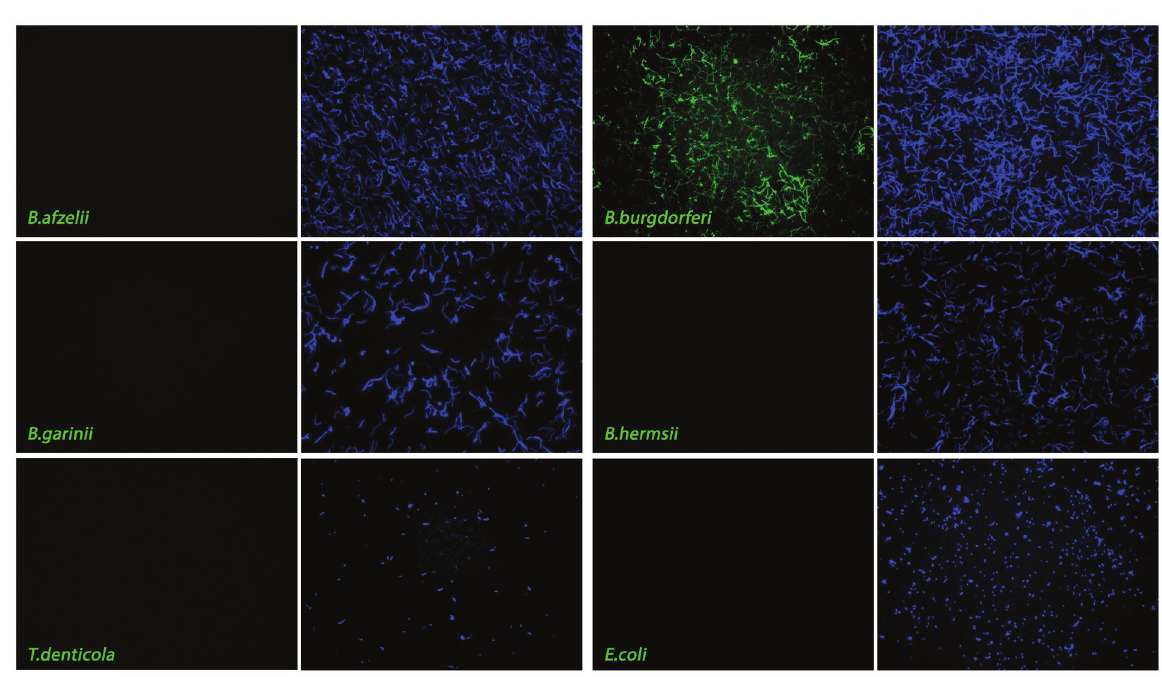
Supplemental Figure 1. Molecular hybridization of FlaB probe with Borrelia strains, T. denticola and E.coli . FlaB hybridization is shown in green, while DAPI counterstain of bacterial targets is shown in blue. Note specific hybridization of FlaB probe with B. burgdorferi sensu stricto and lack of hybridization with other Borrelia strains, T. denticola or E.coli. 400× magnification. See Dataset, data file